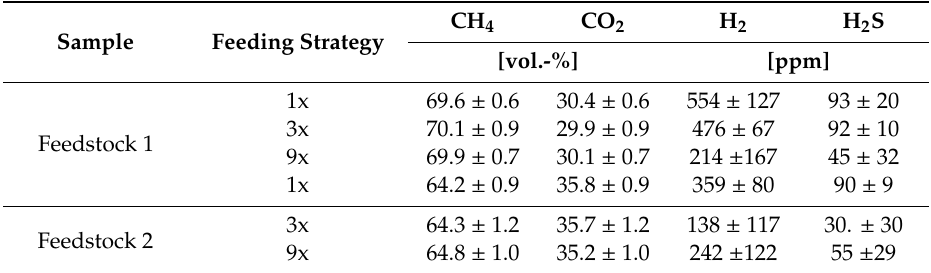
Table 3. Analysis of gas composition from feedstocks 1 and 2 (Ø) (Feedstock 1: n = 24 per strategy